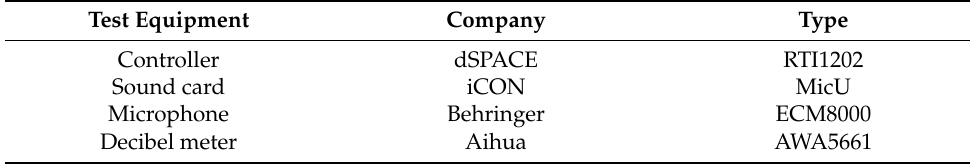
Figure 8. The experimental system: ( a ) the outside of the testing system; ( b ) the inside of the acoustic chamber. Table 1. The test equipment type.